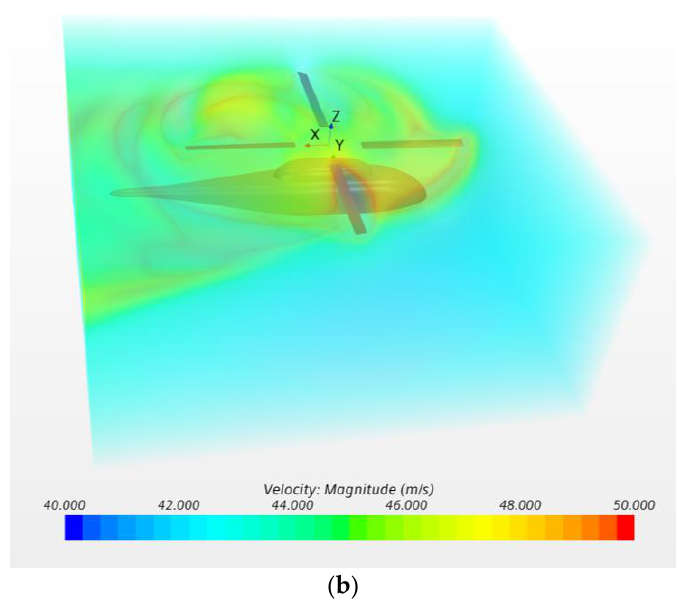
Figure 10. Velocity contours of Robin fuselage / rotor interference flow field. ( a ) µ = 0.151. ( b ) µ = 0.231.